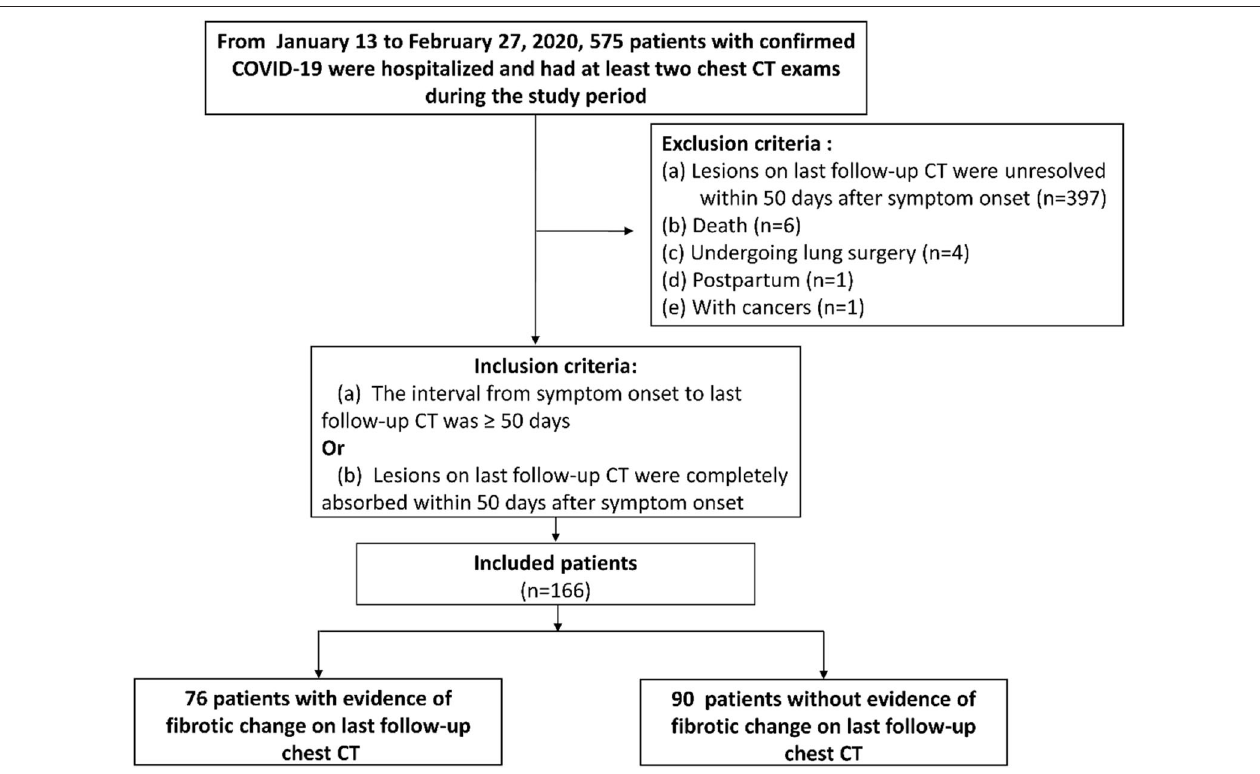
FIGURE 1 | The flowchart of this study. COVID-19, coronavirus disease